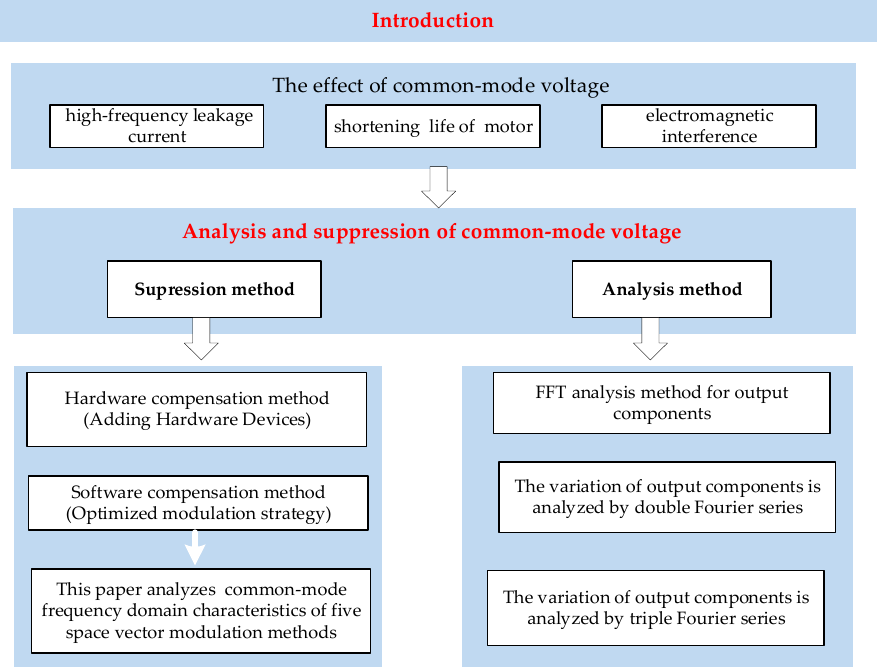
Figure 1. Contribution block diagram of introduction.